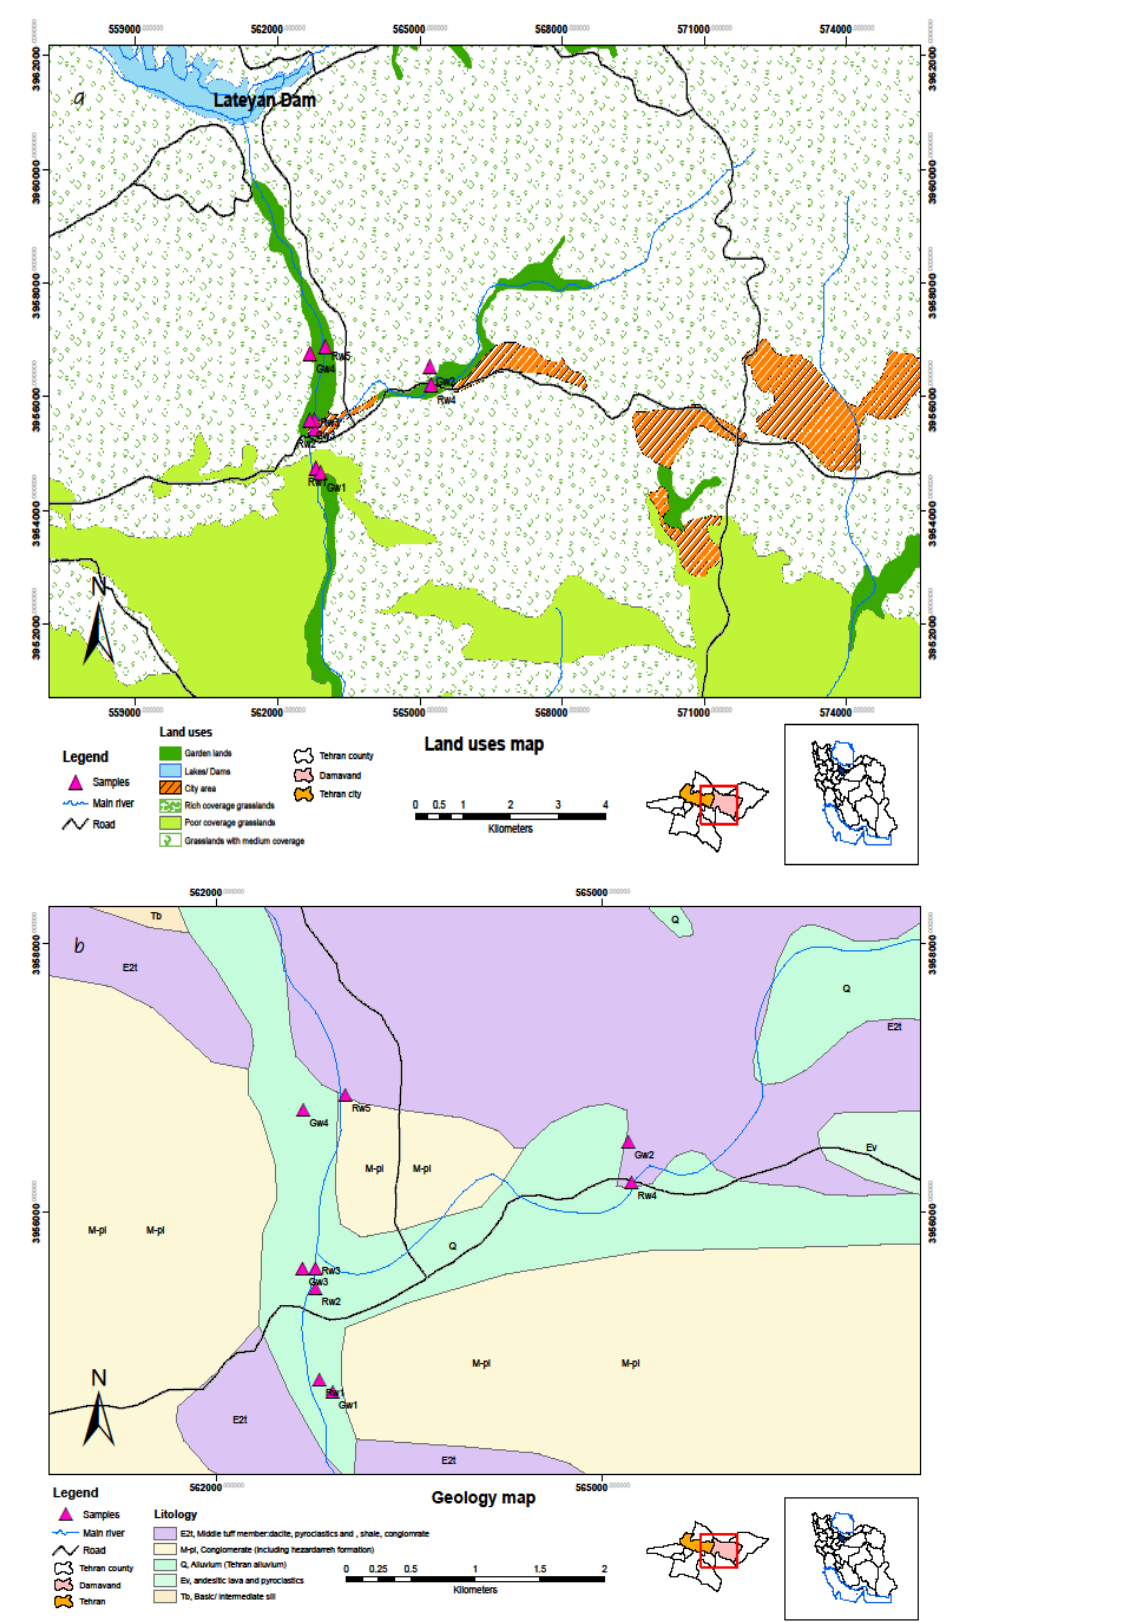
Figure 1. Sampling locations/land uses map (a) and geology map (b) of the study area